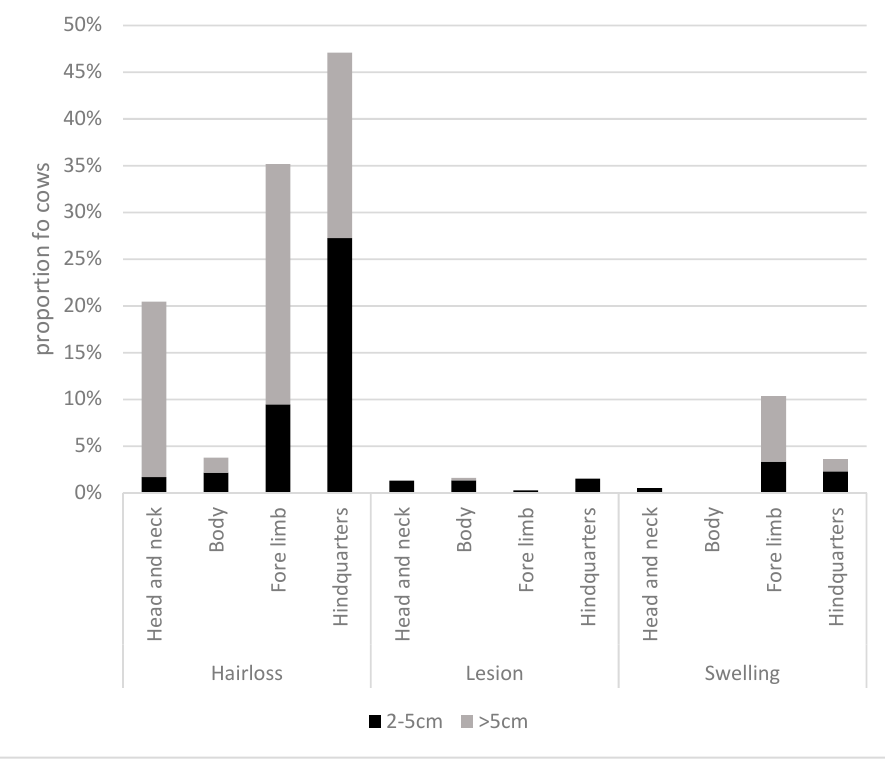
Figure 4. The proportion of cows recorded with hair loss, lesions and swellings in different body regions.